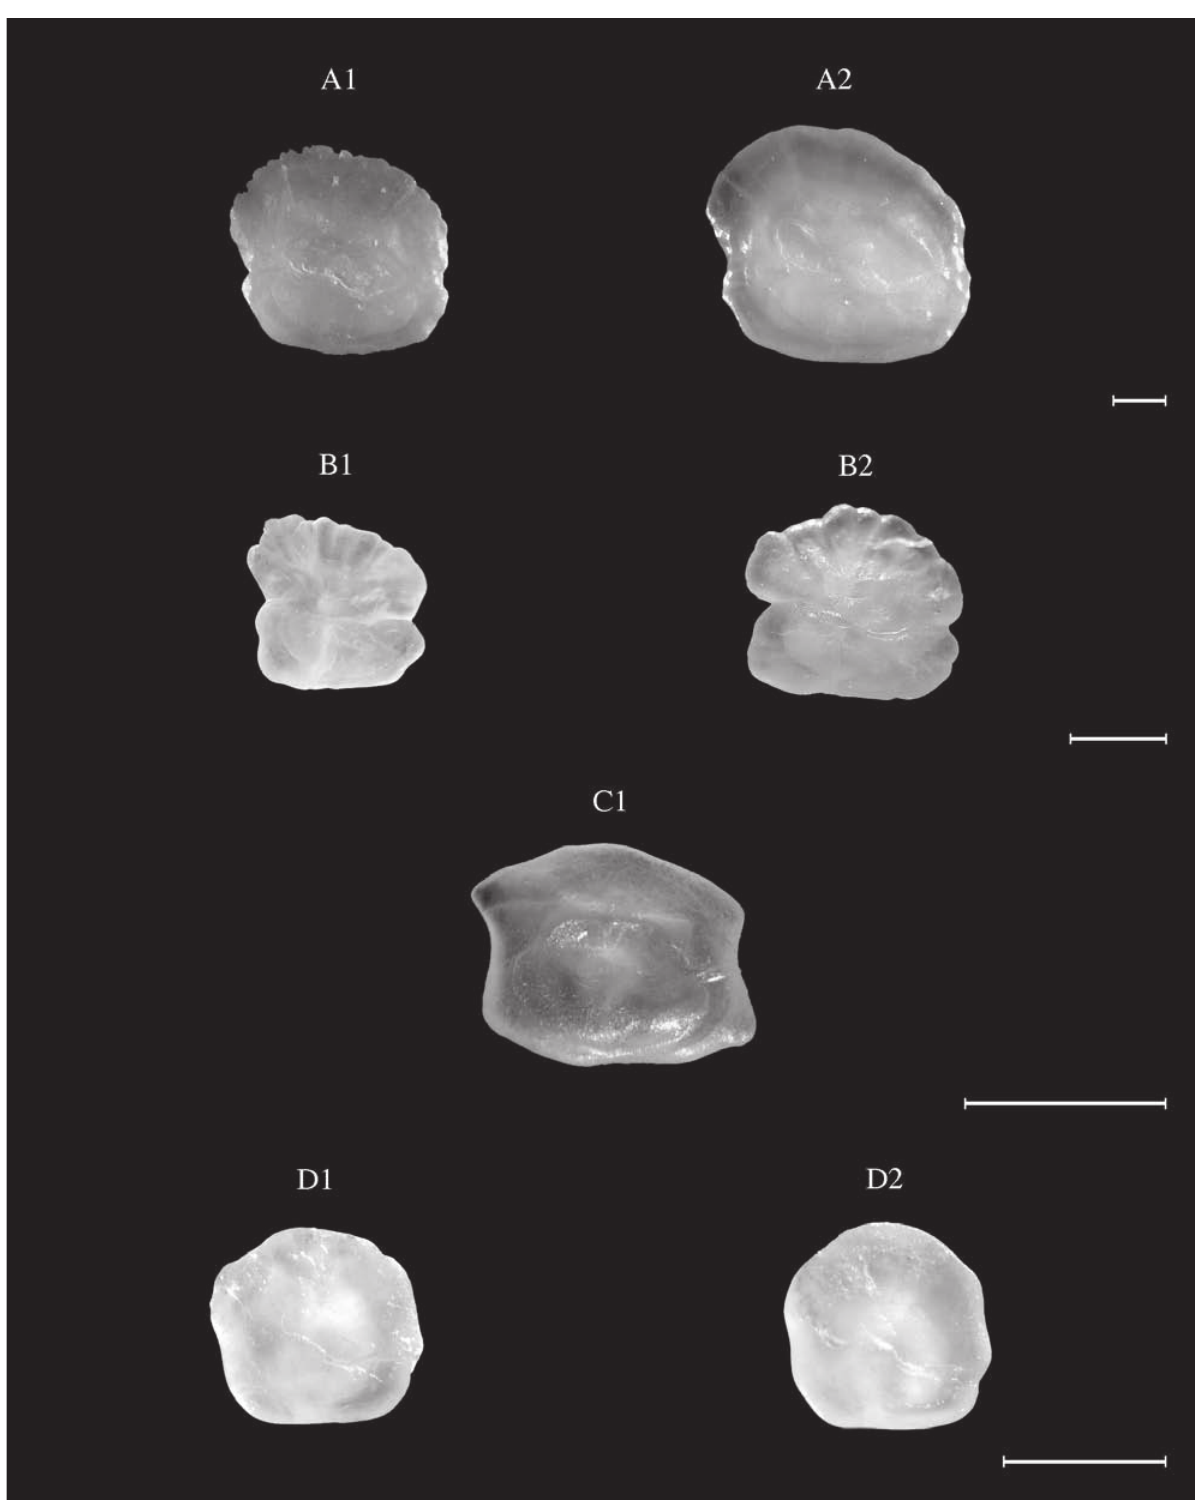
Fig. 81. – Lesueurigobius sanzoi (NEA). TL: A1, 9.9 cm; A2, 13.1 cm. Lesueurigobius suerii (WM). TL: B1, 4.5 cm; B2, 5.0 cm Odondebuenia balearica (WM). TL: C1, 3.4 cm; Pomatoschistus marmoratus (WM). TL: D1, 4.5 cm; D2, 5.0 cm. Scale bar = 1